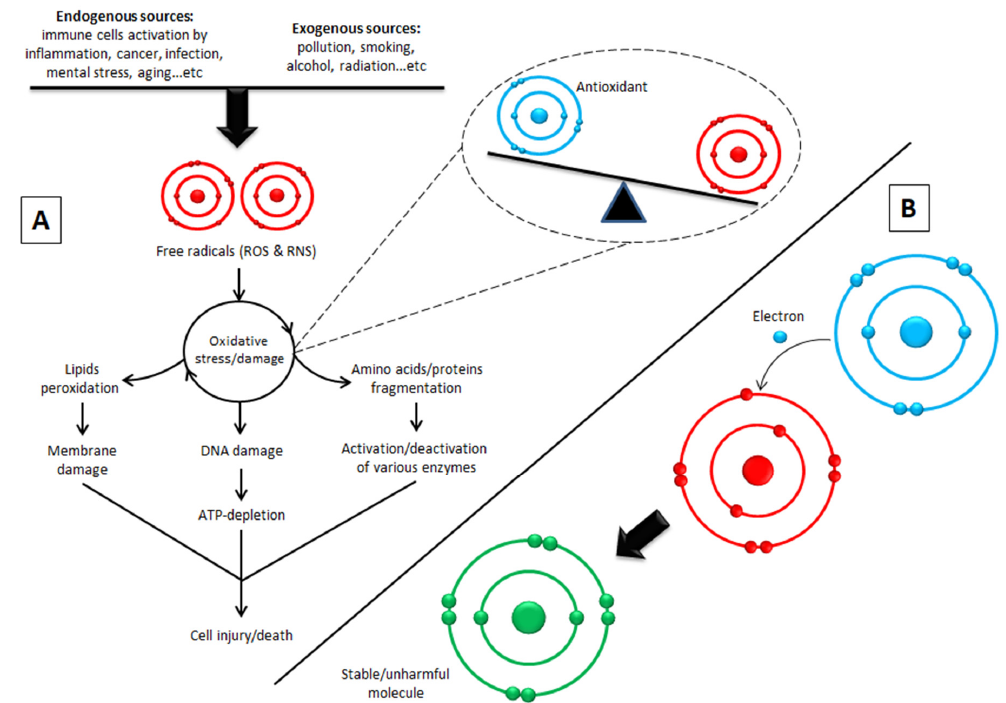
Figure 4. The principal of oxidative damage and the role of antioxidants in scavenging free radicals. ( A ) The free radicals generated from endogenous sources, at limited concentrations, are considered important for regulation of cell maturation, in addition to their role in immune defense. Excessive concentrations of these unstable molecules can result from illness conditions and exogenous sources, and thus lead to oxidative damage (imbalance between free radical and antioxidant concentrations). This status results in cell injury / death based on the extremely high reactivity of free radicals with vital cellular molecules including lipids, amino acids, proteins and DNA. ( B ) Antioxidants are necessary